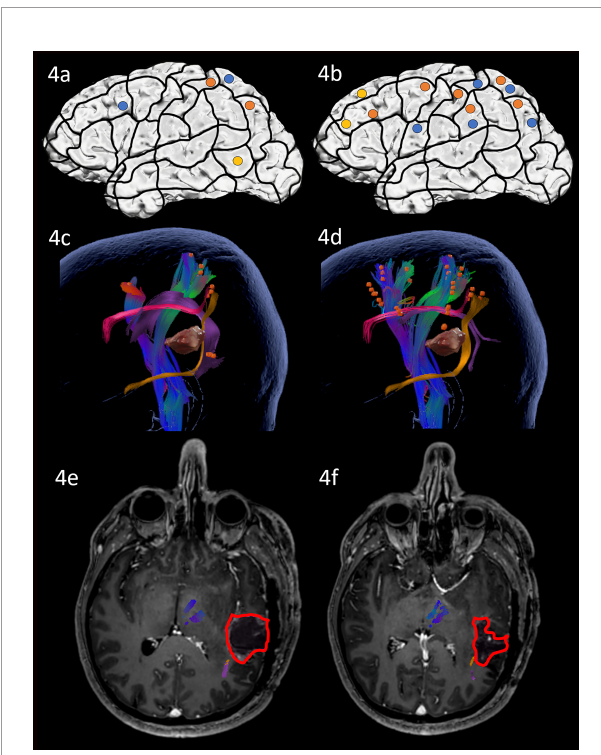
FIGURE 4 | Case 4. Left panels show ON results, right panels AN results. Panels (A, B) nTMS stimulation sites that induced errors; no response and hesitations in orange, semantic errors in yellow and performance errors in blue. Panels (C, D) Fiber tracking results including the lesion, nTMS cortical endpoints in orange and color-coded tracts with CNT in direction-coded, here dark blue, AF in purple, SLF in pink, and ILF in yellow. Panels (E, F) Overlap of tracking and postoperative T1-weighted imaging after elastic fusion with the resection cavity marked in